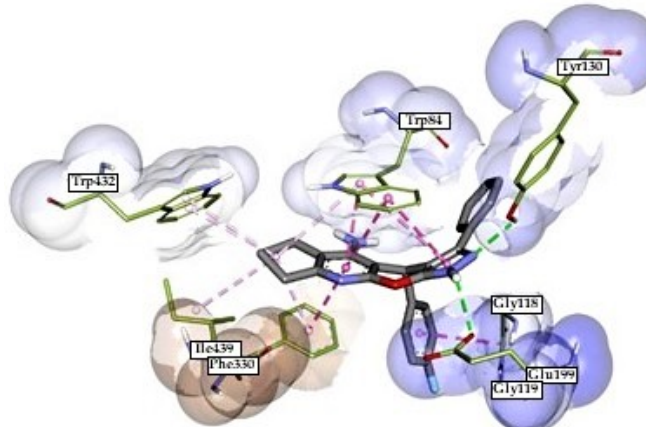
Figure 4. Molecular modeling of 2u in the substrate active site (CAS) of Tc AChE (adapted from [66], with permission from Elsevier). The pyrazole ring forms key H-bonds with Glu199 and Tyr130 and π-π stacking with Trp84. The 4-fluorophenyl moiety forms an amide-π stacking interaction with